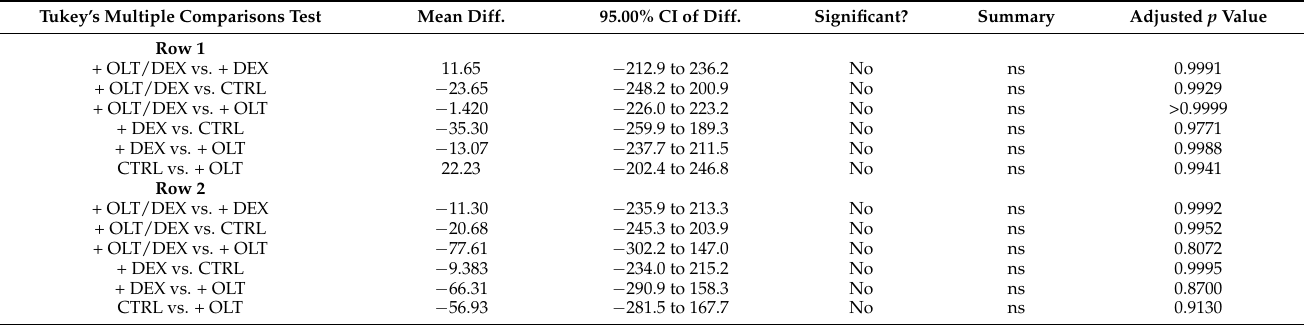
Table 1. Statistical analysis of Figure